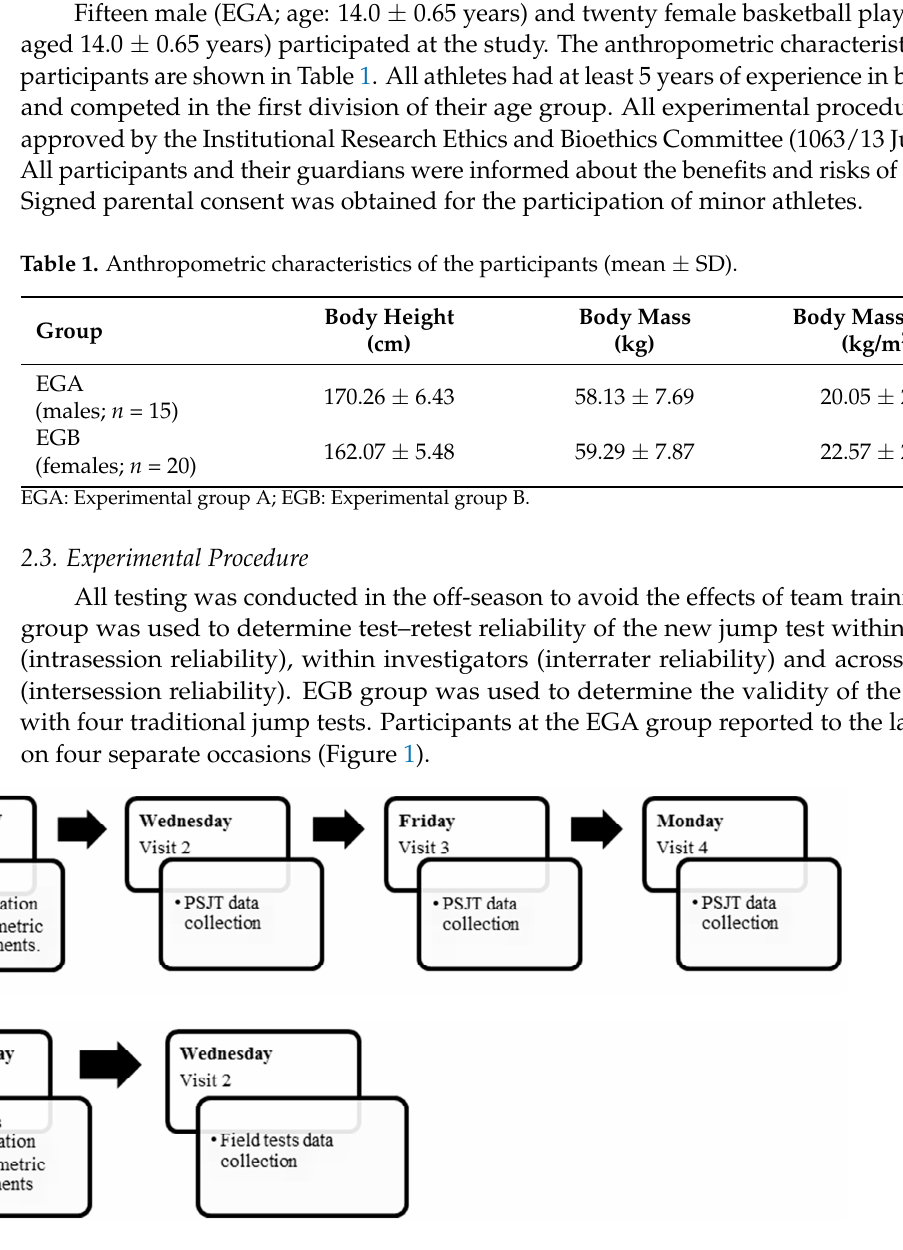
Figure 1. Graphical representation of the design of the study for group A (EGA) and group B (EGB).